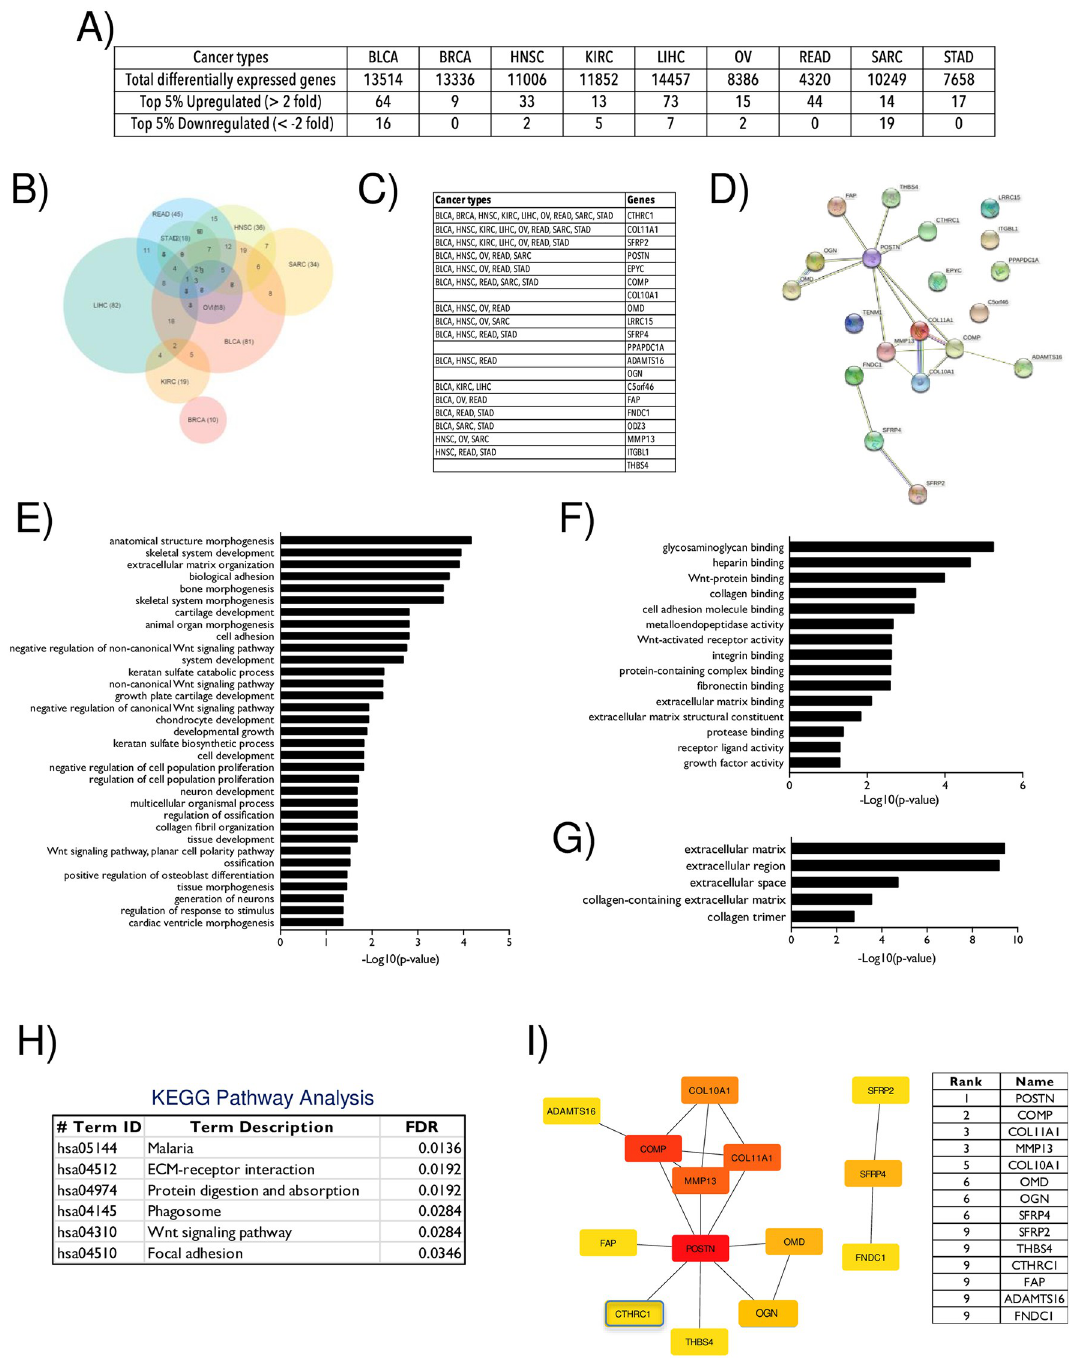
Fig 4. Differential gene expression analysis of CTHRC1. A) The table lists in the 9 selected cancers (BLCA, BRCA, HNSC, KIRC, LIHC, OV, READ, SARC and STAD–as detailed in Methods) the number of differentially expressed genes and the top 5% genes upregulated or downregulated with a 2 fold change (as detailed in Methods). B) This Venn diagram shows the overlap (if any) of the top 5% upregulated genes in the above listed 9 cancers. C) Table lists the 19 overlapping genes between 3 or more cancer types. D) Protein-protein interaction network constructed for CTHRC1 and its 19 differentially expressed genes using the STRING database. BLUE line marks predicted interactions from gene co-occurrence data, GREEN line marks predicted interactions based on gene neighbourhood evidence, PURPLE line marks experimentally determined known interactions, YELLOW line marks interactions based on text mining and the LIGHT BLUE line marks interactions based on database evidence. E-F) Functional enrichment for significant (p < 0.05) (E) biological processes, (F) molecular functions and (G) cellular components in the STRING network analysis